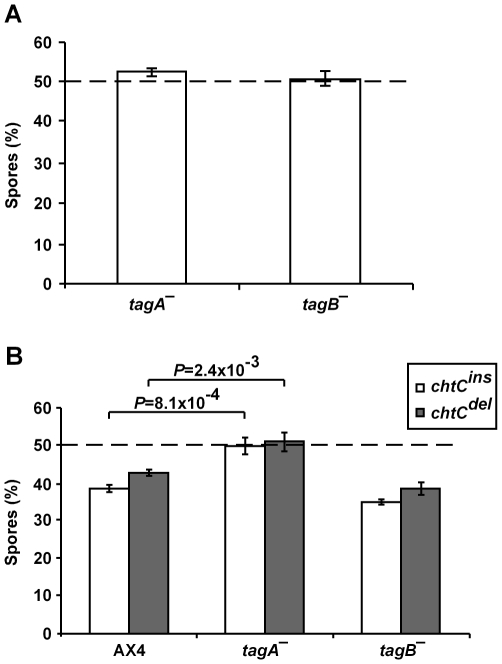
The chtC mutants cheat on tagB–, but not on tagA–.The strains were grown separately and mixed in the appropriate proportions before development in chimera. (A) Spore production of the tagA– and tagB
– mutants when mixed in a 1∶1 ratio with AX4-GFP cells. The data are presented as the proportion (%) of the spores produced by the strain of interest relative to the total spores produced by the chimerae. The results are the means and standard errors of at least 3 independent replications. Both the tagA– and tagB
– mutants form approximately 50% of the spores, showing that they are neutral in terms of cheating behavior. (B) Spore production of AX4-GFP, tagA– and tagB
– when mixed in a 1∶1 ratio with chtCins and chtCdel cells. The data are presented as the proportion (%) of the spores produced by the strain of interest relative to the total spores produced by the chimerae. The results are the means and standard errors of at least 3 independent replications. In the chimerae with either chtC mutant, the tagA– mutant forms significantly more spores and the tagB– mutant is not significantly different, compared to AX4 (Student's t-test). Individual P-values are indicated above the bars for the significantly different strains.